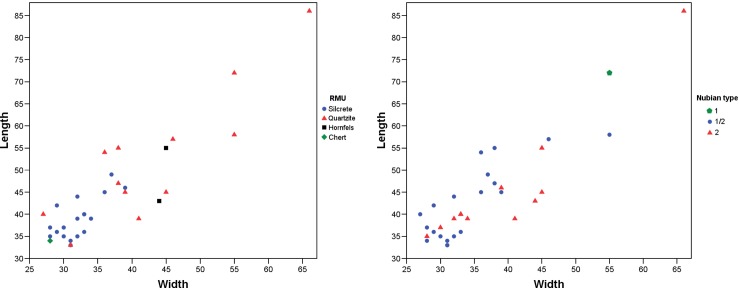
Scatter plots showing length by width (in mm) for Nubian-like cores from UPK7 with indication of raw material (left) and Nubian core type (right).